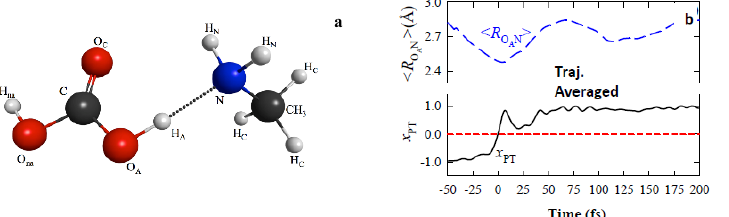
Fig 1. (a) The reactive H-bonding complex between CA and methylamine. For color-coding and the location of the various atoms see Ref. [4]. (b) Ab initio molecular dynamics results for proton transfer when complex immersed in aqueous solution [4]. Dashed blue line is the O A −N H -bond separation R OAN versus time. Solid line is the 10 trajectory- averaged normalized proton coordinate, χ PT, defined as the difference of the O A H A and H A N stretch coordinates. The time t = 0 is set for χ PT = 0, the middle point in the proton coordinate when the proton is transferred from the oxygen to the nitrogen atom. The red dashed line indicates χ PT =